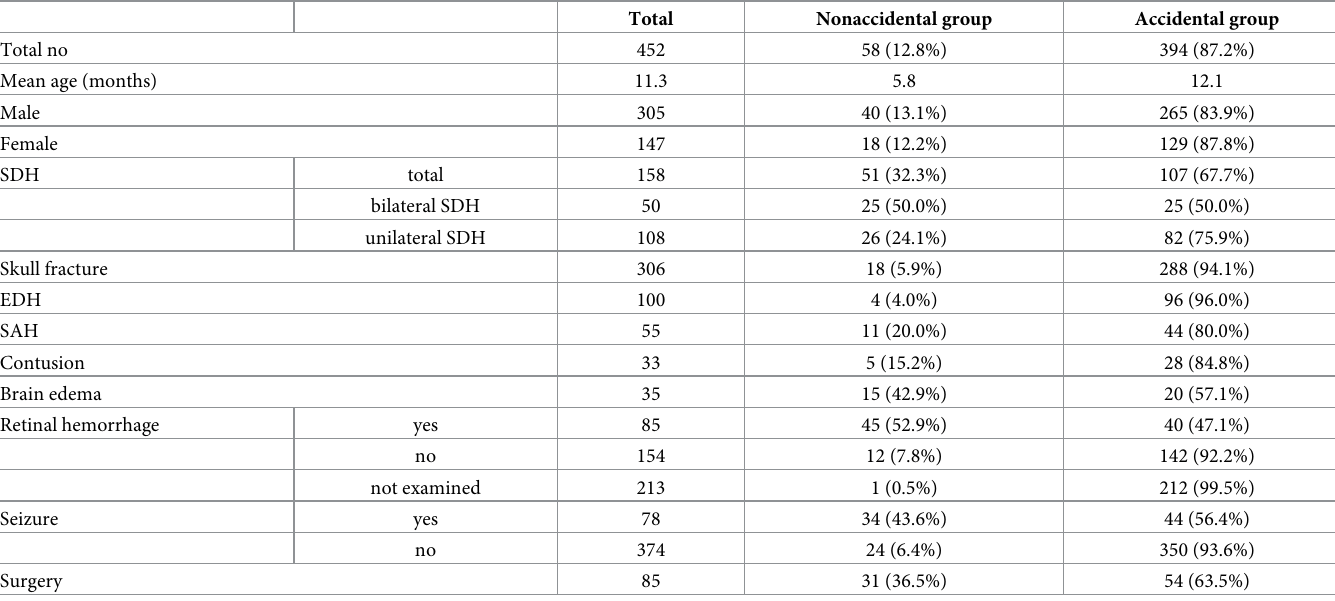
Table 2. Comparison of demographic and clinical presentations.